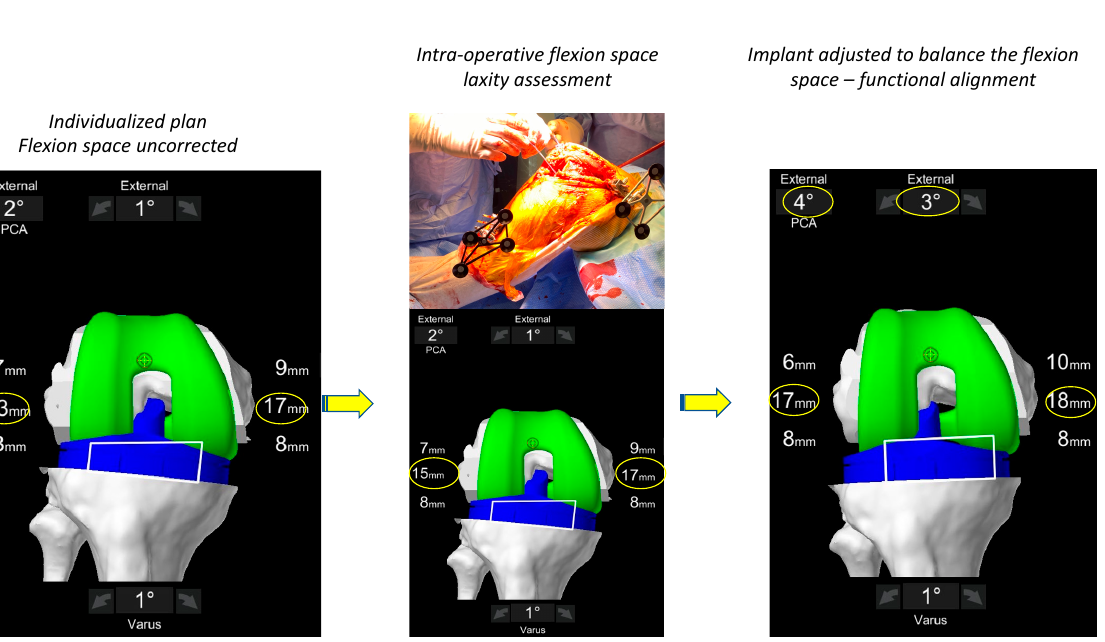
Individualized plan Flexion space uncorrected